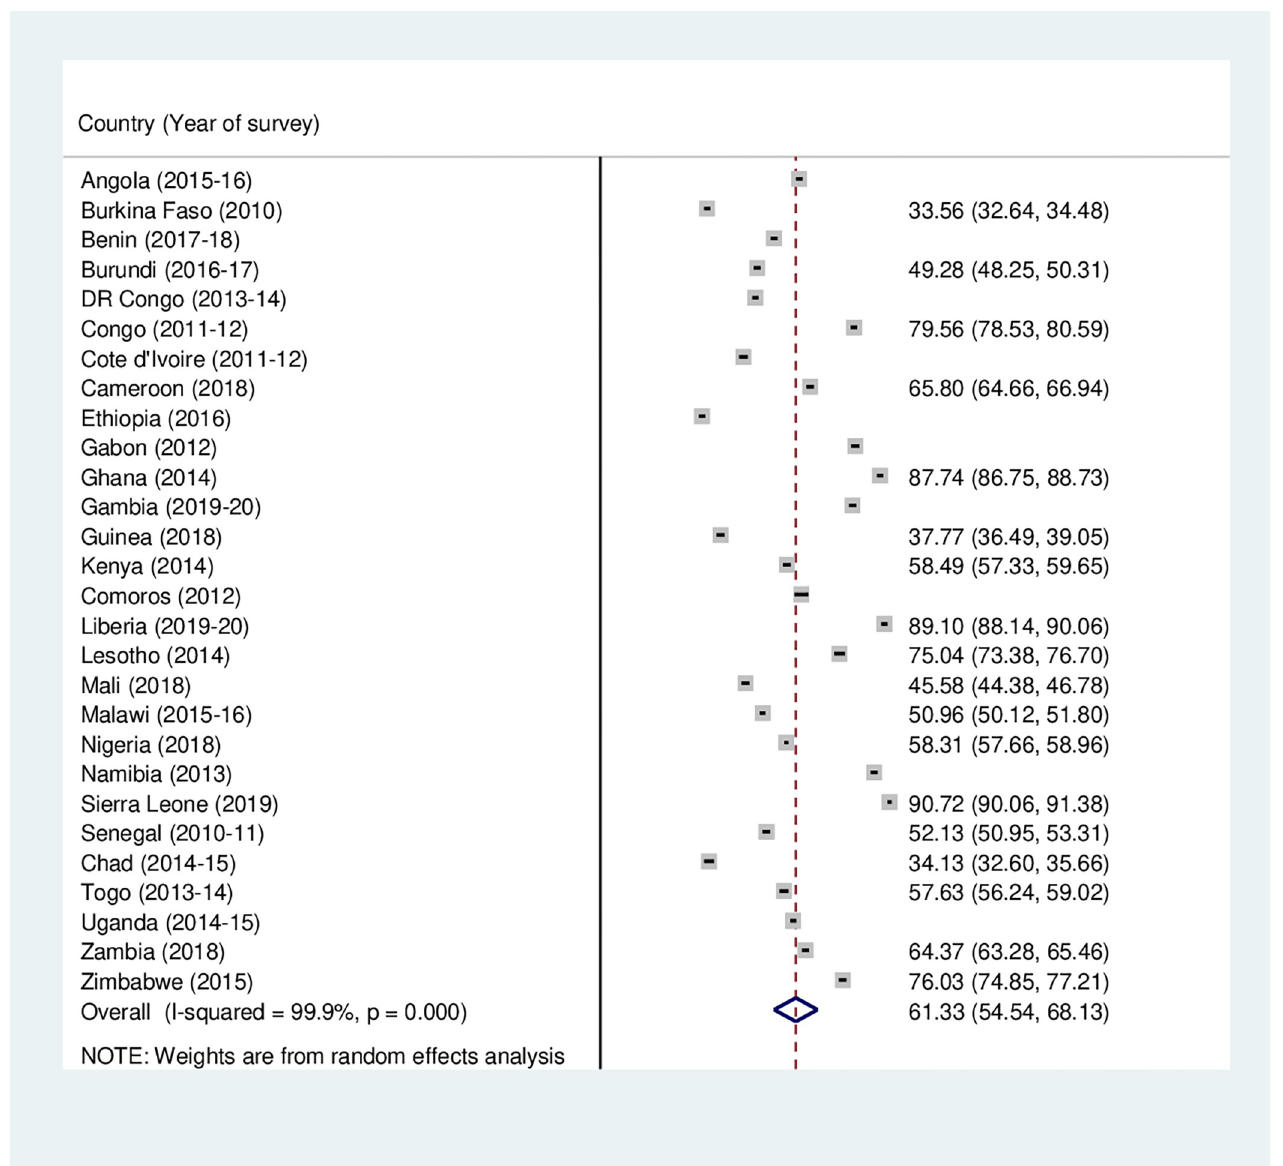
Fig 1. Forest plot showing the prevalence of four or more antenatal care visits among women in sub-Saharan Africa.